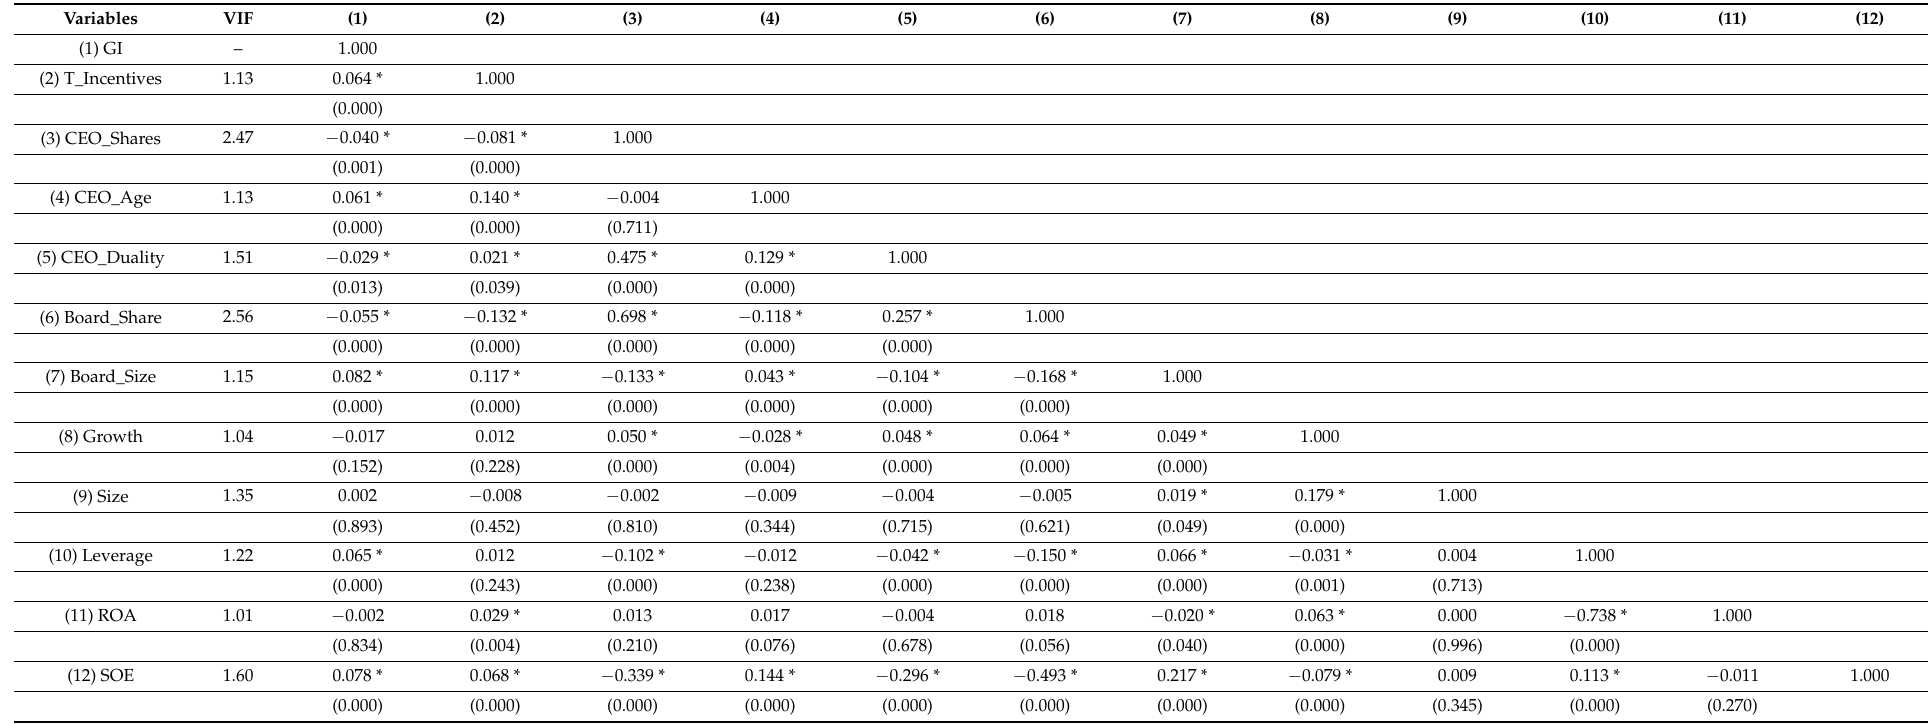
Table 3. VIF test and Pearson’s